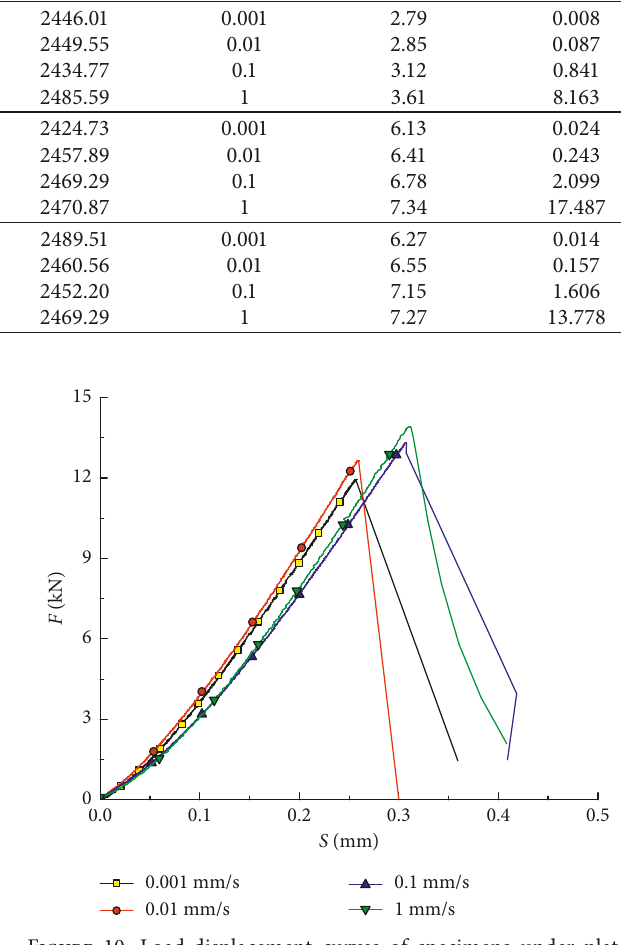
Figure 10: Load-displacement curves of specimens under plate loading.